Question: Generate an informative caption for the figure above.
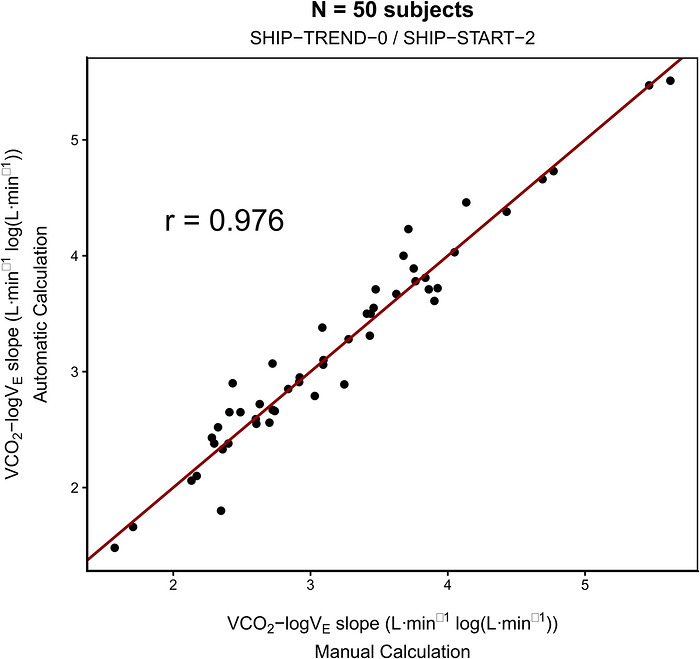
Answer: Correlation scatter plot between manual and automated calculations N = 50 individuals from SHIP cohorts.